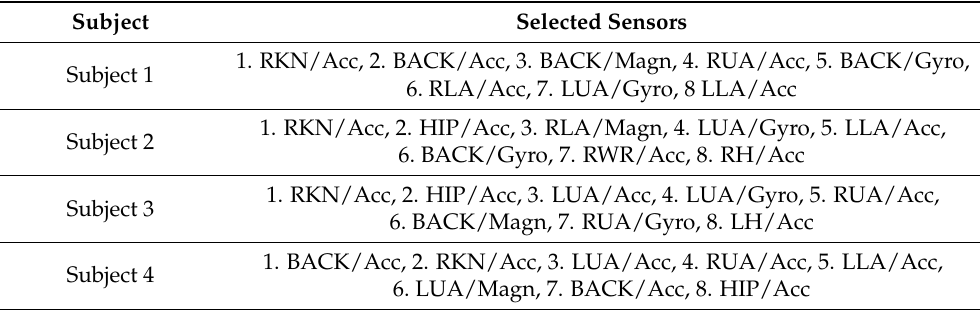
Figure 3. The relationship between the accuracy and the ensemble scale of the ELS in OPPORTU- NITY dataset. Table 1. Selection results of important sensors in OPPORTUNITY based on mixed diversity measure.